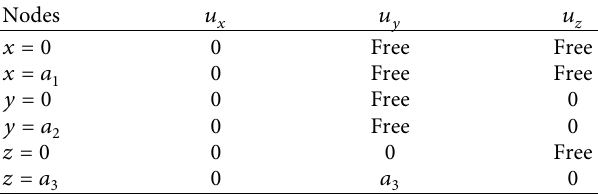
Table 1: Boundary conditions for the FE model of the unit cell. Nodes u x